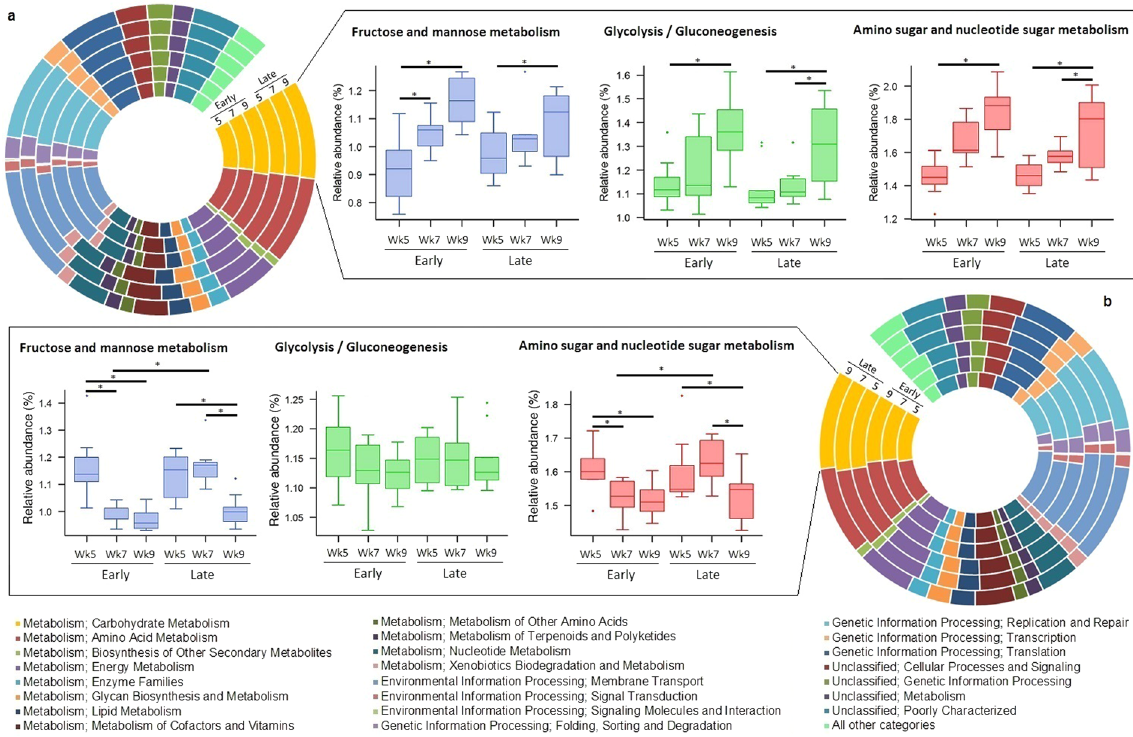
Figure 6. PICRUSt predicted summary of COG categories from 16S amplicon sequencing of ( a ) ruminal and ( b ) faecal microbiomes. Relative abundances of Level 2 KEGG pathways are depicted by calf age within treatment group (weaning age) in circular barplots. Relative abundances of the three most abundant L3 KEGG pathways involved in Carbohydrate Metabolism (Fructose and Mannose Metabolism, Glycose/gluconeogenesis and, Amino sugar and nucleotide sugar Metabolism) at different ages (5, 7, or 9) subjected to weaning at either 6 weeks (Early) or 8 weeks (Late) of age are also presented within the boxes. * P < 0.05 for the shown comparisons of L3 pathways (See Supplementary Tables 3–6 for complete KEGG